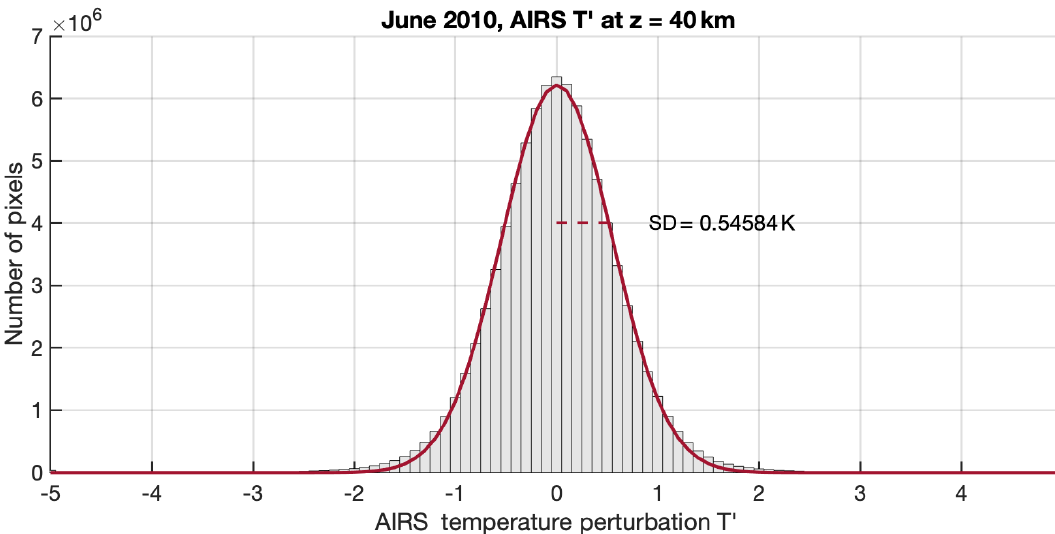
Figure B1. Histogram of all detrended AIRS temperature perturbations at z = 40km globally during June 2010. A Gaussian fit to this distribution is shown by the red line, which has a standard deviation of around 0.55K as